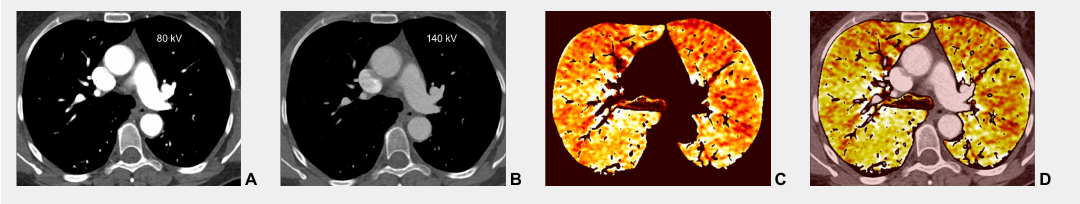
Technical principles. The dual-energy system with two X-ray tubes permits simultaneous 80 ( A ) and 140 kV ( B ) image acquisition in order to generate an iodine map ( C ) fused with mediastinal reconstructions ( D ).